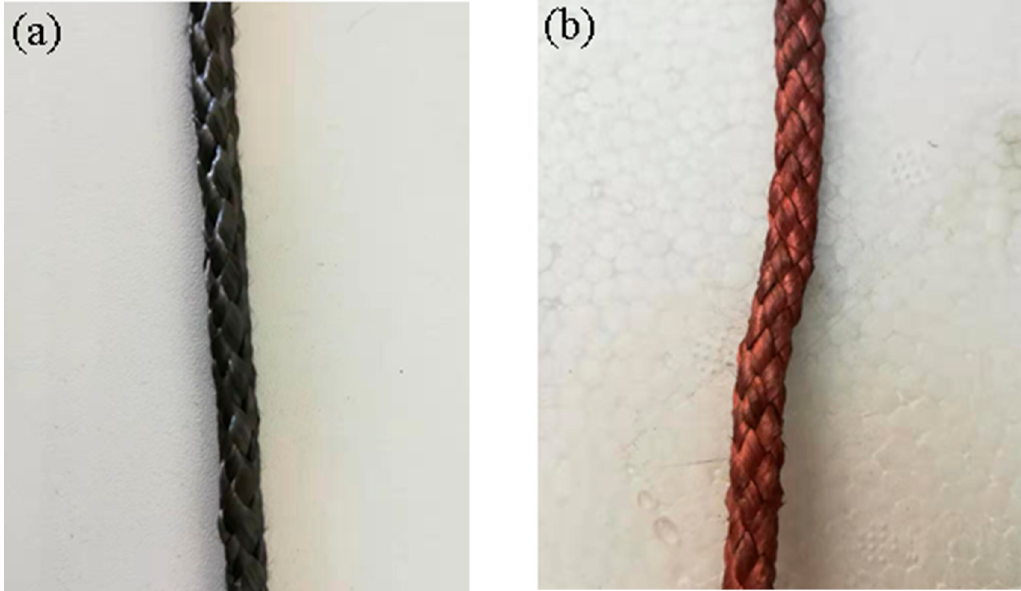
Figure 1. The macro morphology of braided carbon fiber rope: ( a ) uncoated braided carbon fiber rope; ( b ) Cu-coated braided carbon fiber rope.